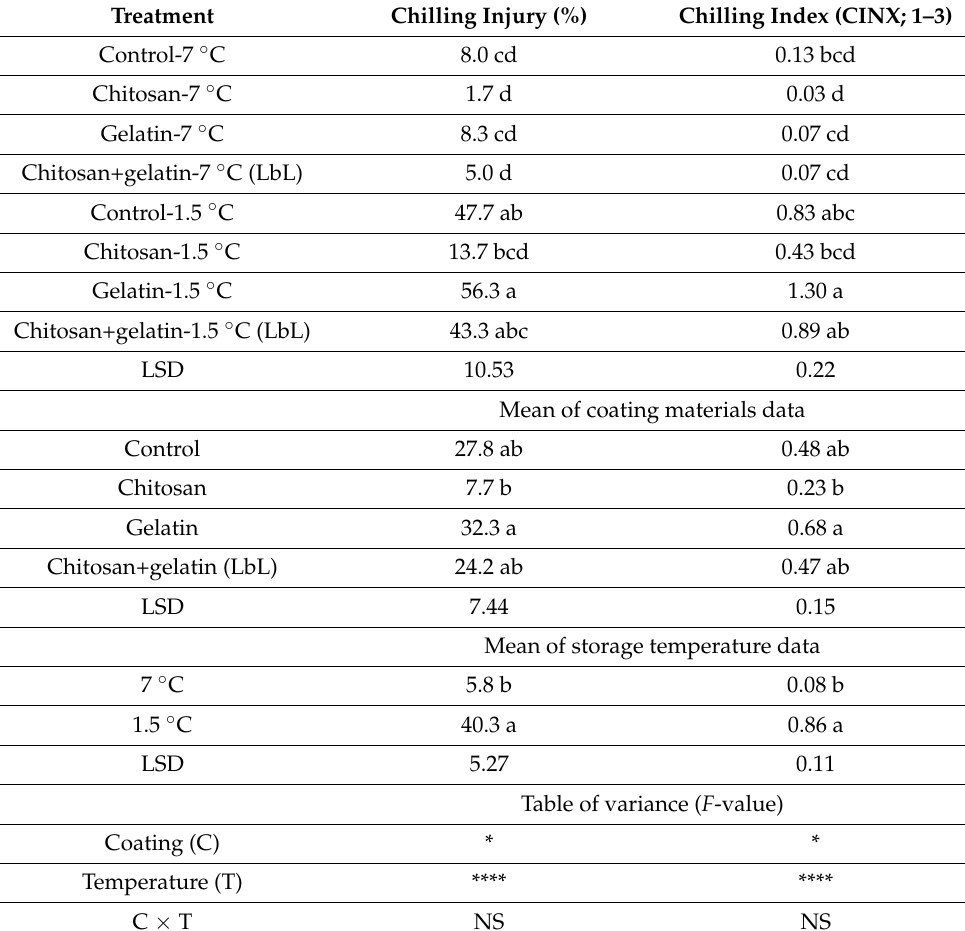
Table 2. The effects of different coating materials and storage temperatures on red pepper fruit quality, in terms of chilling injury (%) and chilling index (0–3) after 21 d at 7 ◦ C or 1.5 ◦ C, followed by 3 d at 21 ◦ C. Mean data from three harvests are presented; each harvest consisted of two boxes with 20 fruit in each box.